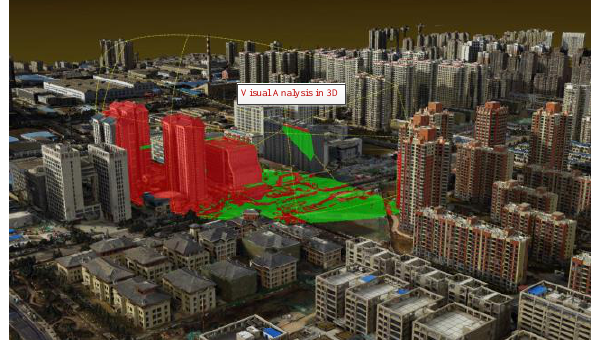
Figure 6.Analysis of sunshine in different seasons.